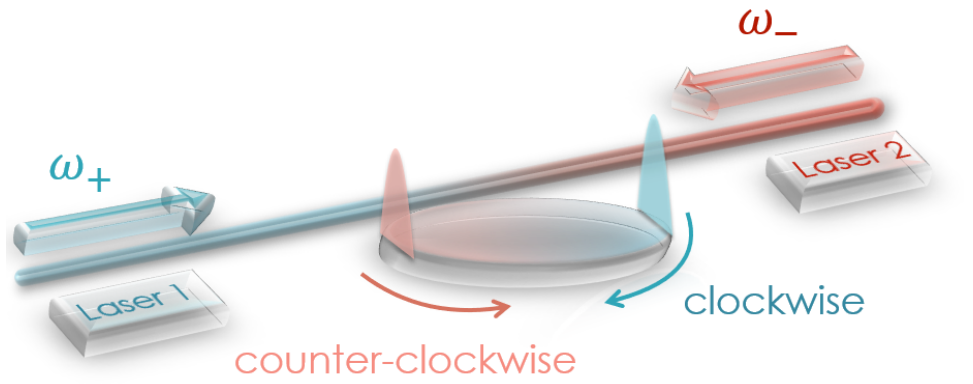
Figure 1. A schematic illustration of the bidirectionally pumped